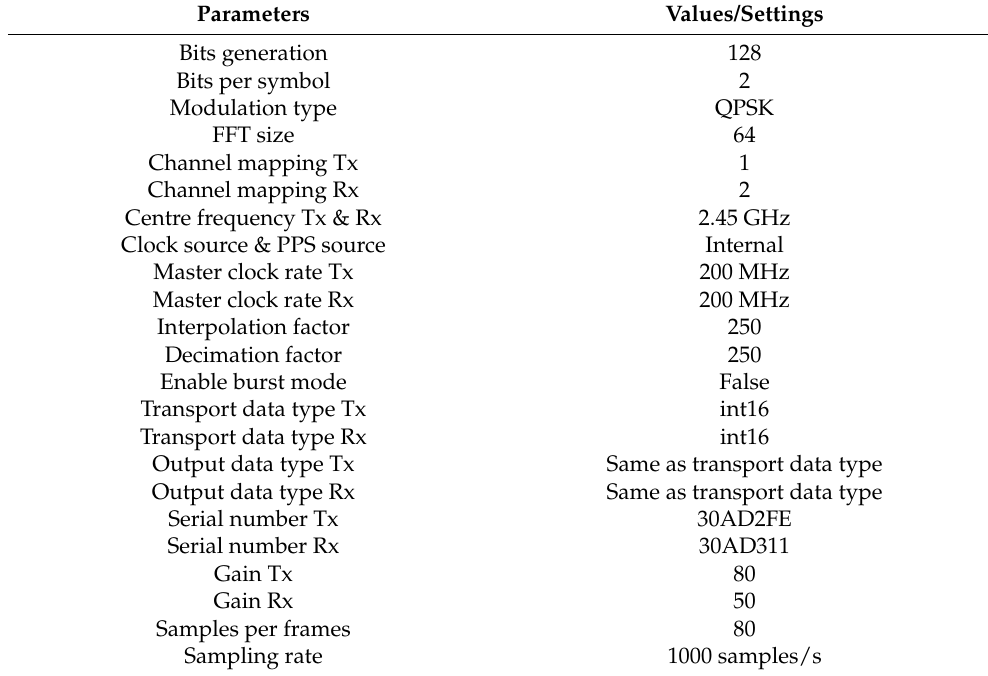
Table 2. Software-defined parameters setting of the non-contact smart sensing system.